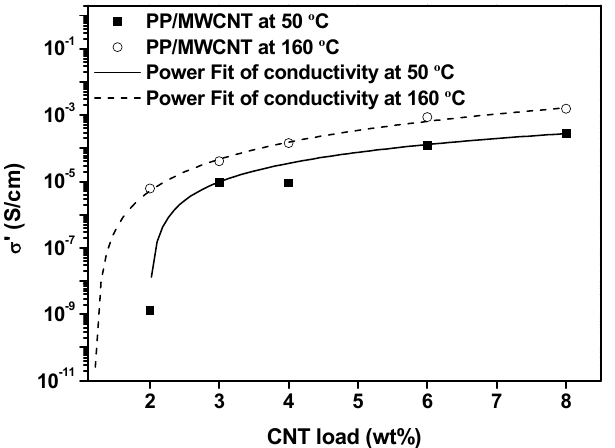
Figure 9. Electrical conductivity (DC) as a function of MWCNT content at 50 °C and 160 °C fitted to the equation of the statistical percolation theory (see